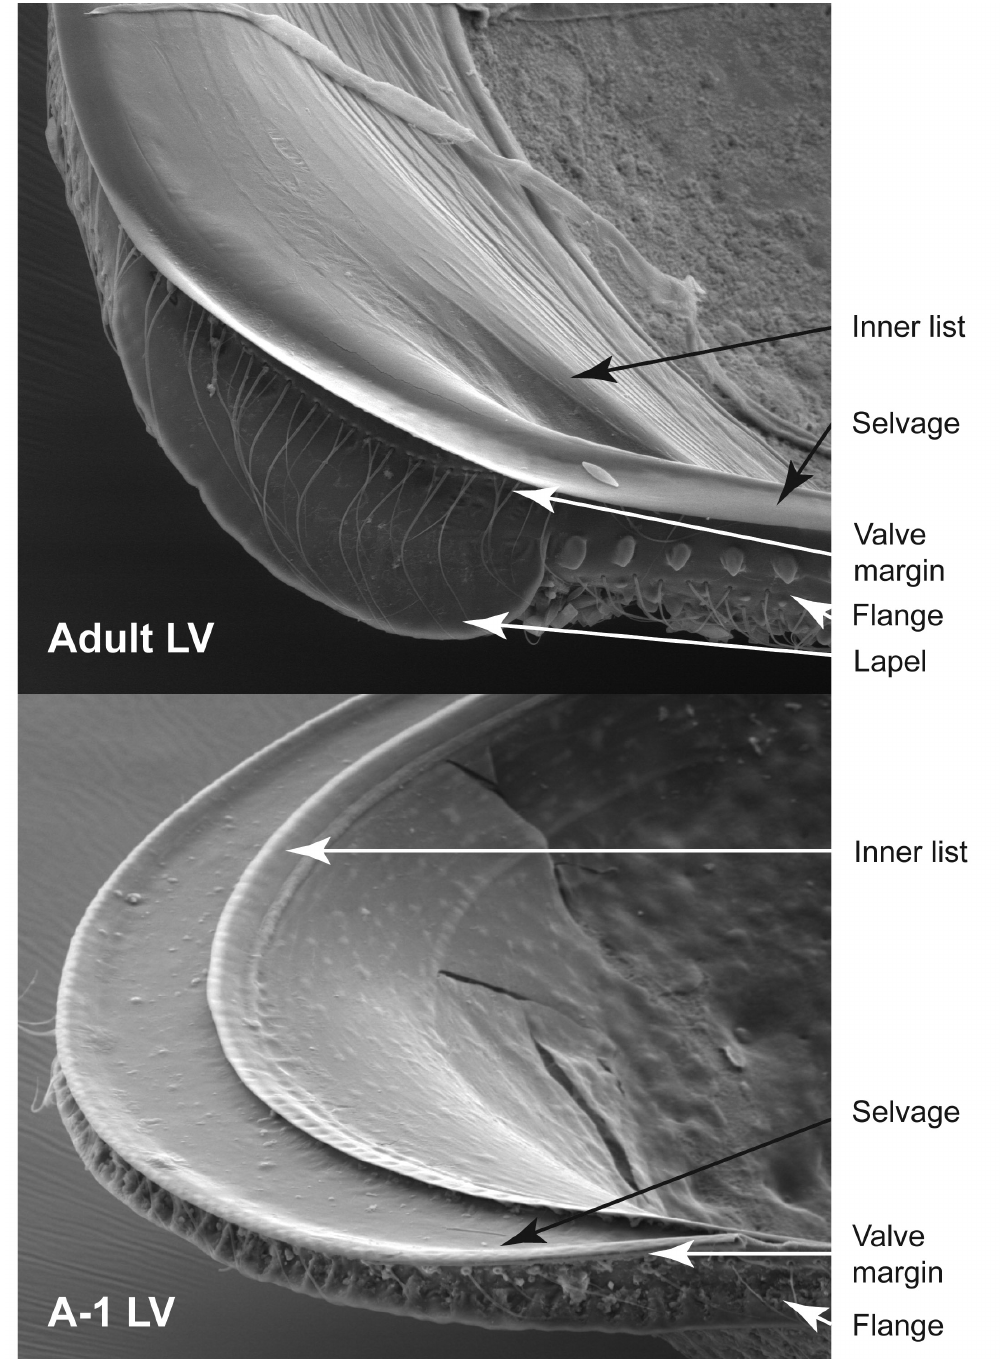
Fig. 1. SEM photographs showing detailed internal views of the anterior portion of the right valves to highlight key